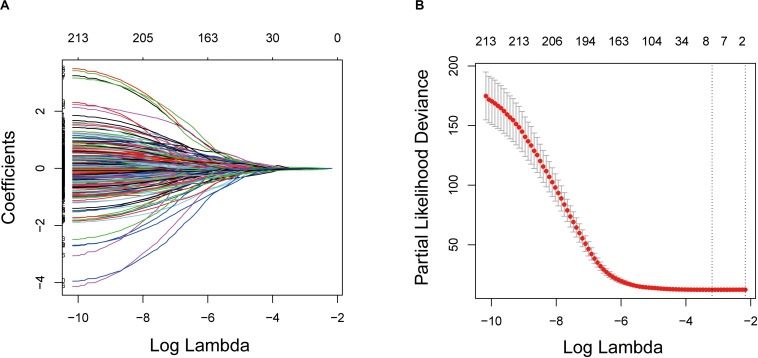
Establishment of prognostic gene signature by LASSO regression analysis. (A) LASSO coefficient profiles of the 214 genes in the training cohort. (B) A coefficient profile plot was generated against the log (lambda) sequence. Selection of the optimal parameter (lambda) in the LASSO model for the training cohort. LASSO: the least absolute shrinkage and selection operator Cox regression model.